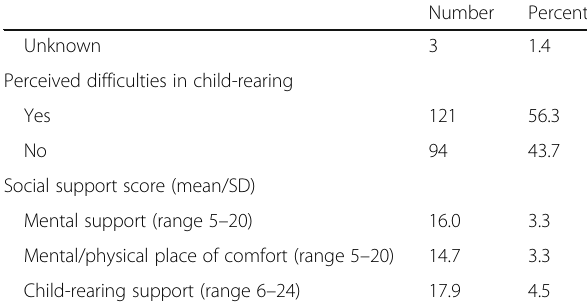
Table 1 Sociodemographic and socioenvironmental characteristics of mothers living in a house different from their house before the disaster ( n = 215)